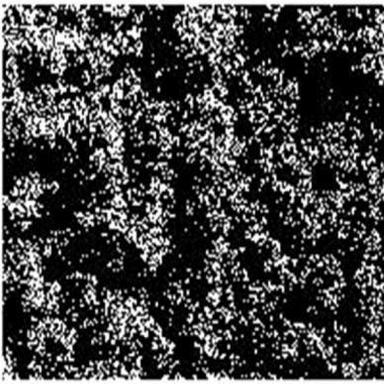
X-ray microanalysis of powders obtained by wet and dry milling: distribution maps of the Fe, Co, Nb, chemical elements on the starting sample (a) and the 5 h wet-milled sample (b) and 5 h dry-milled sample (c).